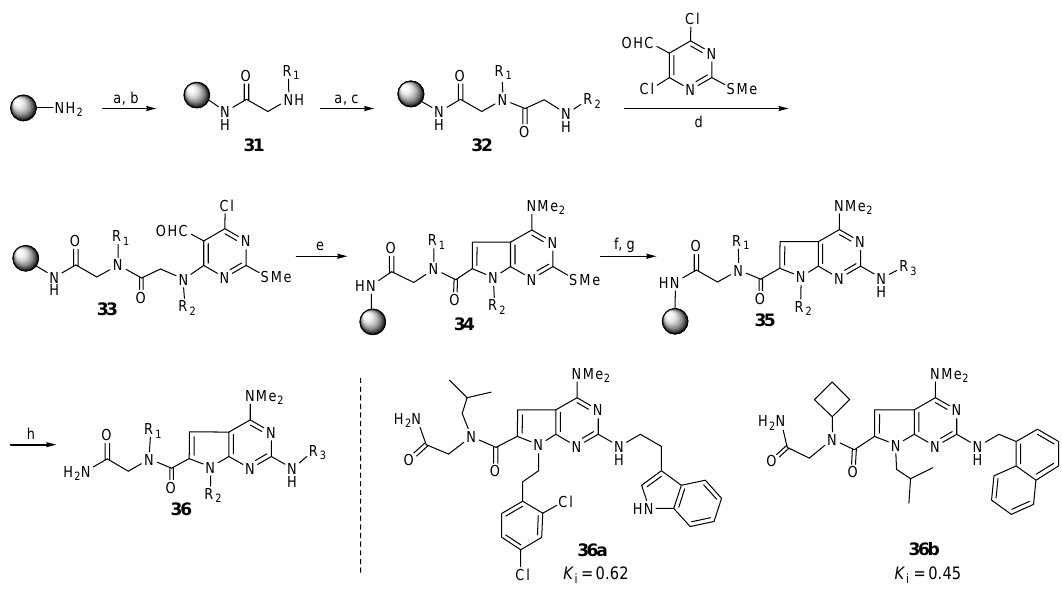
Figure 9. Design of dual Mdmx/Mdm2 inhibitors based on pyrrolopyrimidine